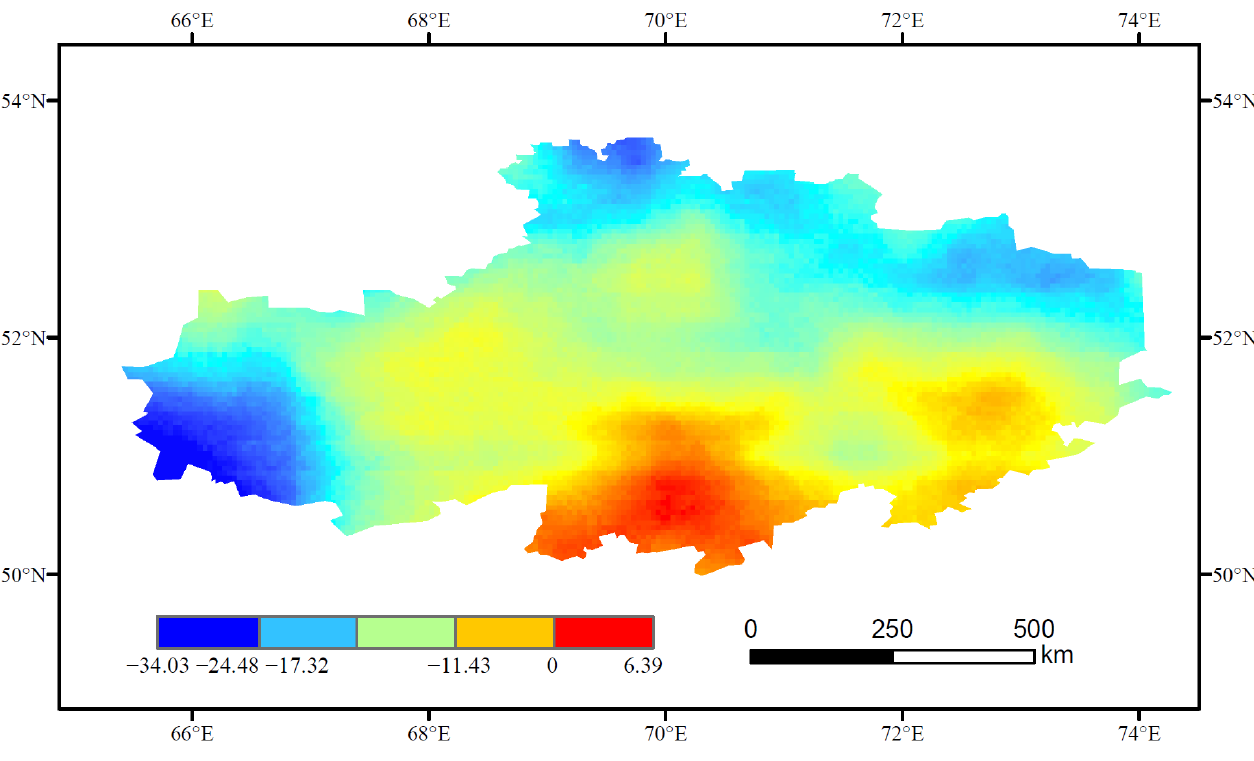
Figure 3. Average annual rate of change in PET in Akmola State, 1991 – 2021. Table 3. Percentage of annual average change in PET in Akmola State.